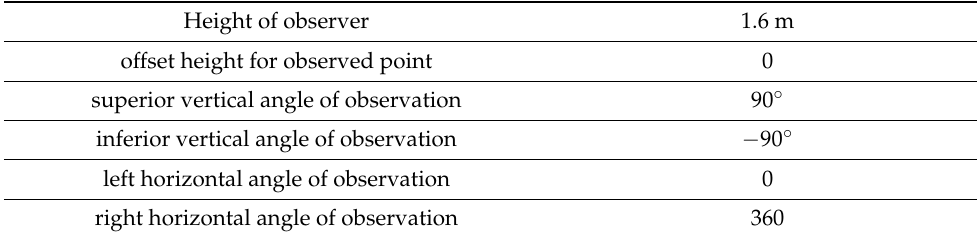
Table 1. main parameters used in the viewshed analysis. Table 1. Main parameters used in the viewshed analysis.